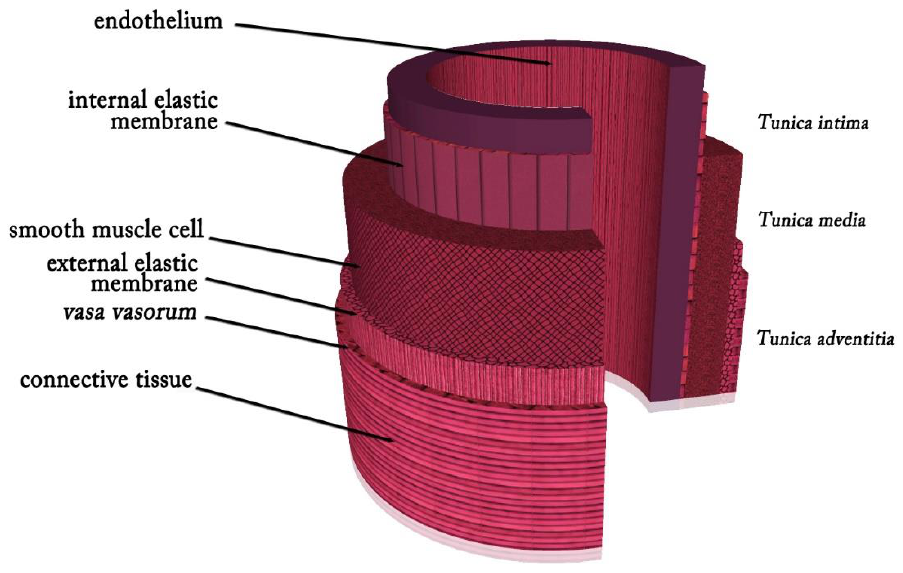
Figure 1. Layers of an